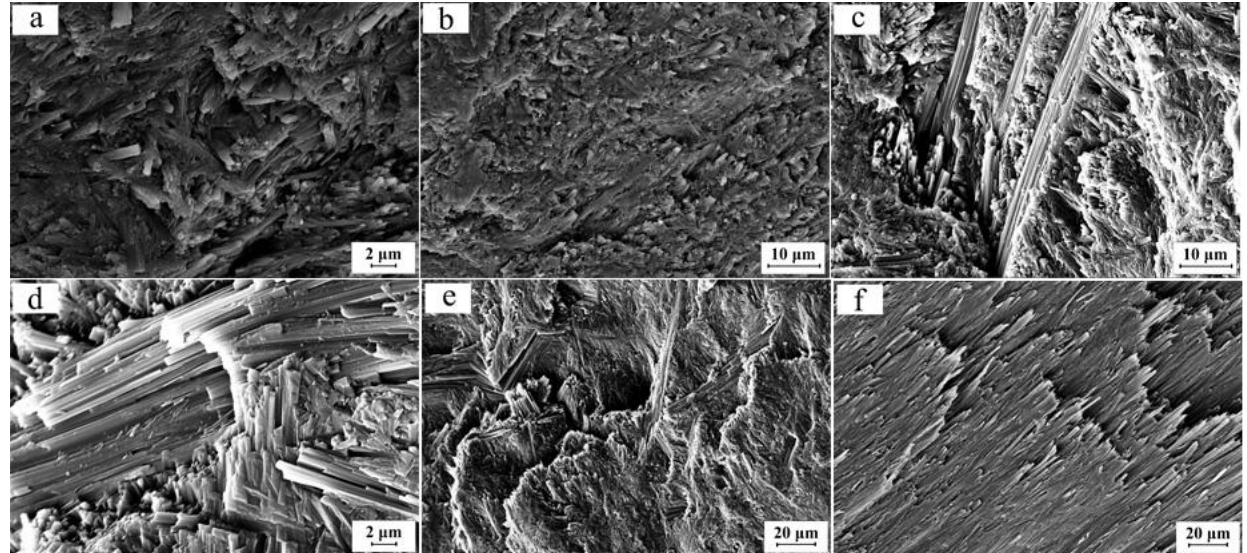
Figure 5. Typical SEM micrograph. Interlaced fibrous texture. ( a , b ) Felted–fibrous interlaced texture. The granule size is generally in the range of 0.33 –25 μm, and there is no prominent orientation. ( c – e ) Fibrous interlaced texture, where fibers are long and fine, and the length of some exceeds 20 μm. ( f ) Parallel fibrous blastic texture with a rigid orientation, visible along the surface of the cleavage.